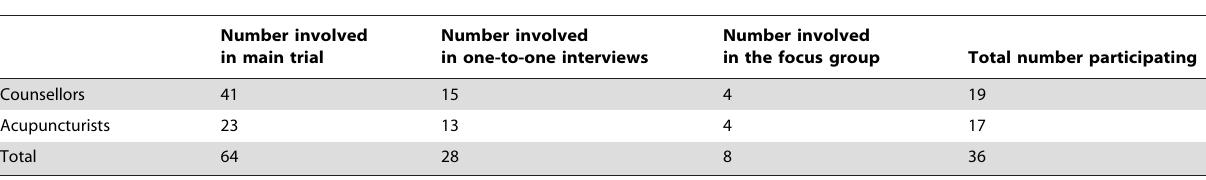
Table 1. Breakdown of study